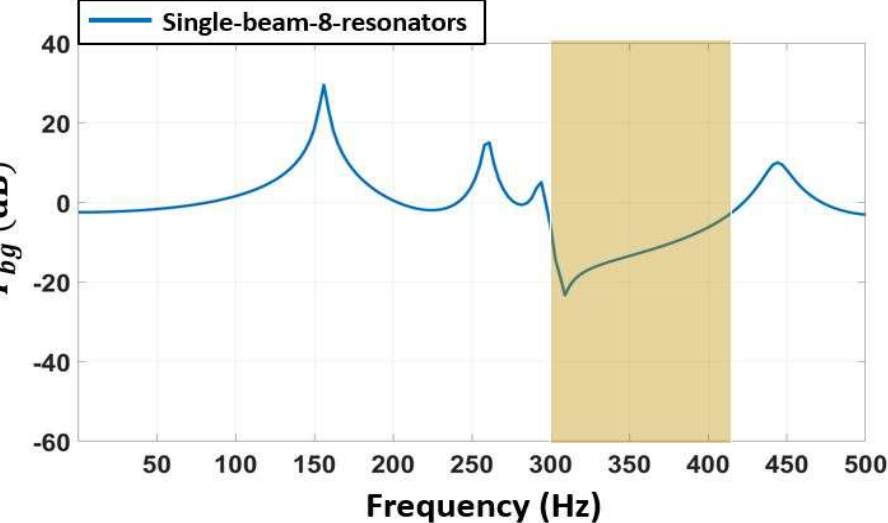
Figure 5. Transmissibility bandgap of a single-horizontal beam metamaterial with 8 unit cells. The material and design parameters were taken from Table 1. Results show a significant frequency bandgap at 300–415 Hz.